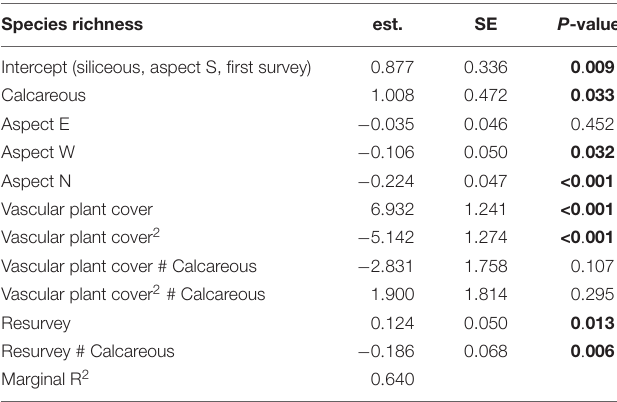
TABLE 4 | Effects of bedrock, aspect, vascular plant cover (linear and quadratic), first survey/resurvey, and chosen interactions on species richness. Species richness est. SE P